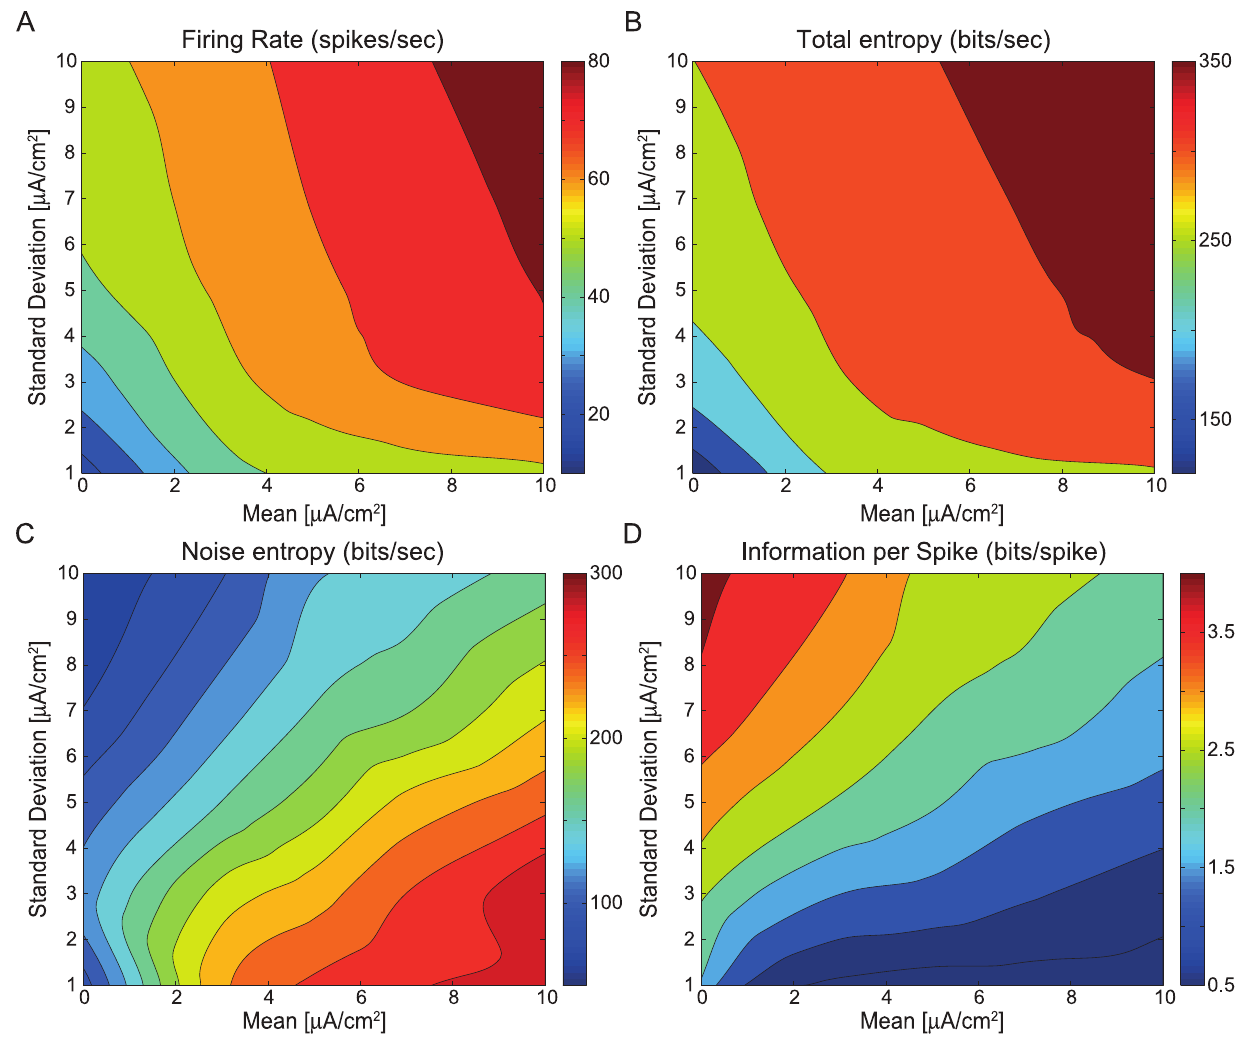
Figure 3. The effect of stimulus statistics upon the rate, timing and precision of action potentials. A. Firing rates (spikes s 2 1 ) of the spiking neuron model evoked by white noise current stimuli with different means and standard deviations. The current stimuli used in A–D were identical to those in Figure 3A. B. Total entropy (bits s 2 1 ), C. Noise entropy (bits s 2 1 ), and D. Information rate per spike (bits spike 2 1 ) of the spiking neuron